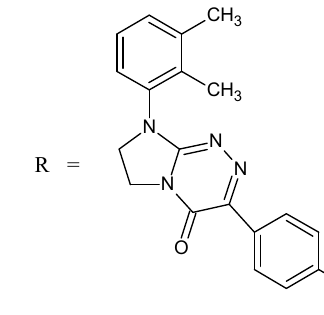
3 , 0.1 M CH 3 COOH, and 0.1 M acetate buffers with a pH of 3.5, 4.0, and 4.5)